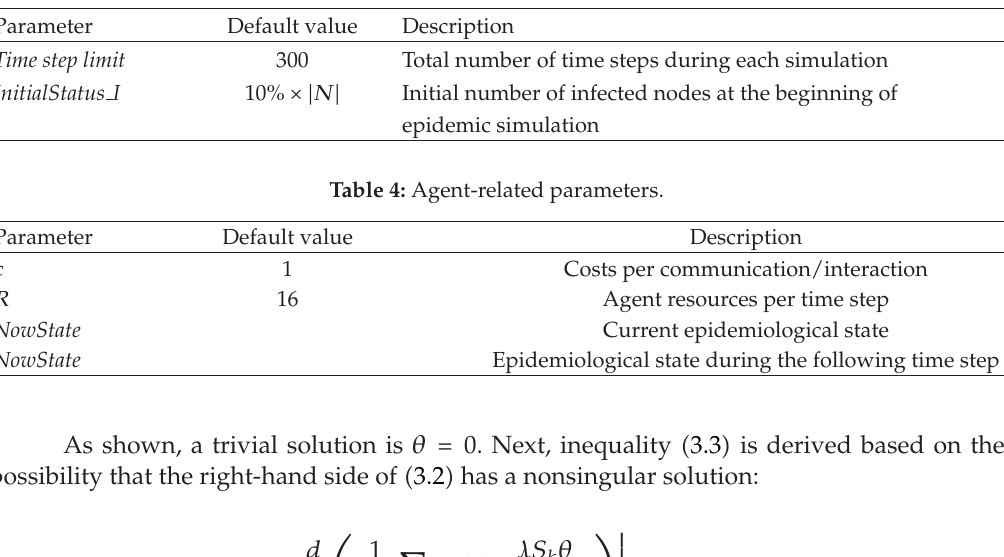
Table 3: Experimental parameters.